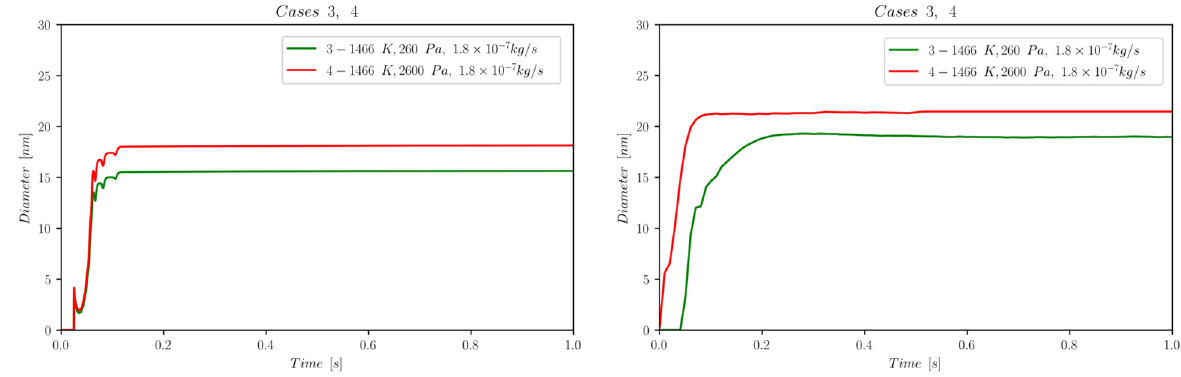
Figure 7. Temporal evolution of 𝑑̅ for cases 3 and 4, belonging to subclass iii (pressure variation); ( left ) MoM, ( right ) PBM.